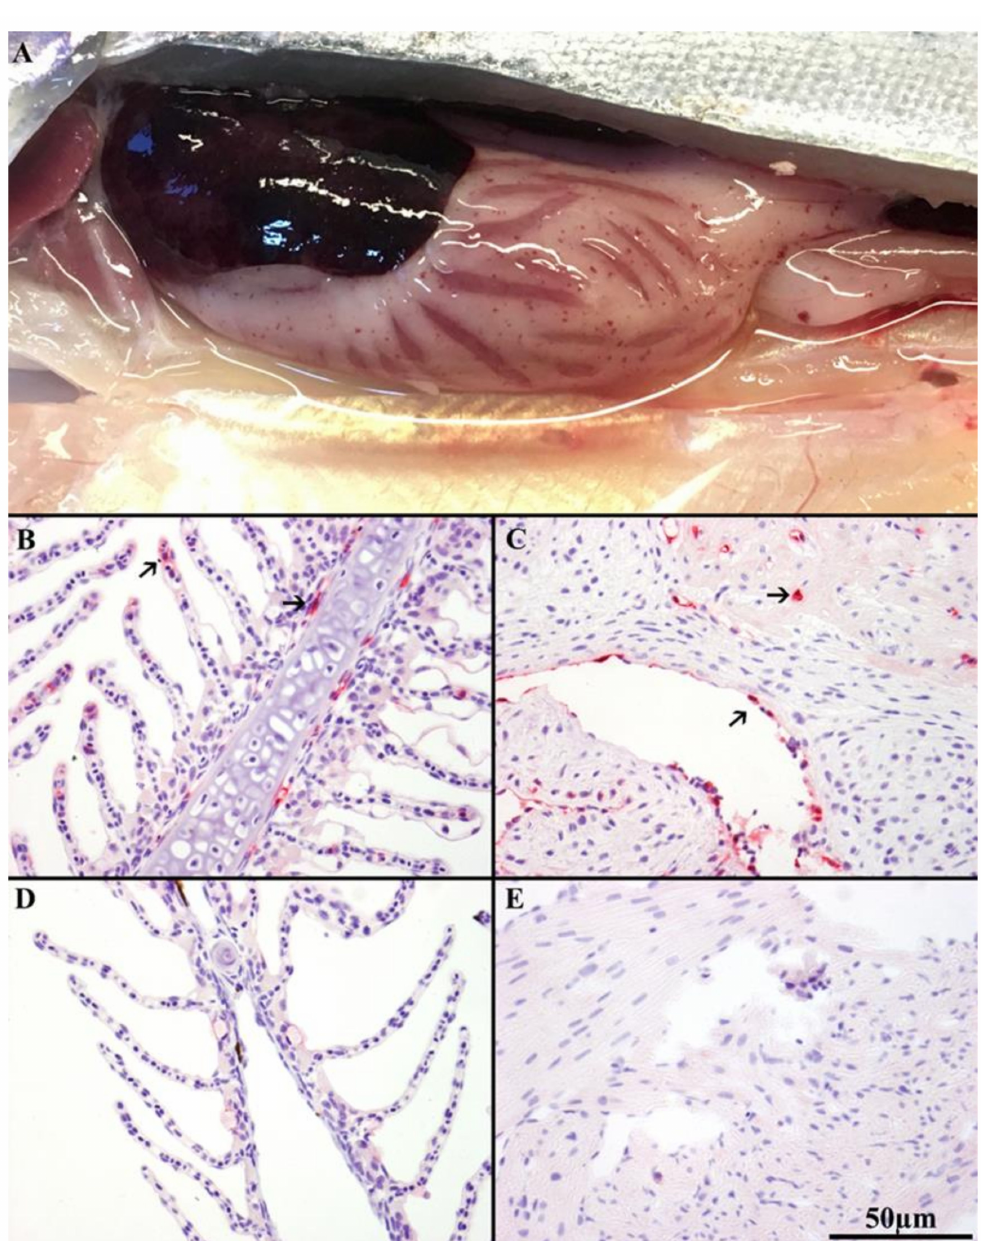
Figure 3. ( A ) Autopsy showing visible internal clinical ISA disease signs such as liver discoloration, enlarged spleen, ascites, and petechial hemorrhaging of the visceral fat in HDg ISAV exposed individuals at 9DPC. Immunohistochemistry (IHC) of ISAV-infected Atlantic salmon ( Salmo salar L.) with anti-ISAV NP rabbit antibody. ( B ) Histology of gill of infected LDg fish sampled at 9DPC, showing strong positive staining (arrows) of epithelial cells of interior lamellae, endothelial cells, and pillar cells. ( C ) Histology of heart of clinical HDg fish at 9DPC showing strong positive staining (arrows) of endothelial cells covering the spongious heart muscle and the compact heart muscle. ( D , E ) show negative staining of the gill and heart tissues from the sampled negative control fish at